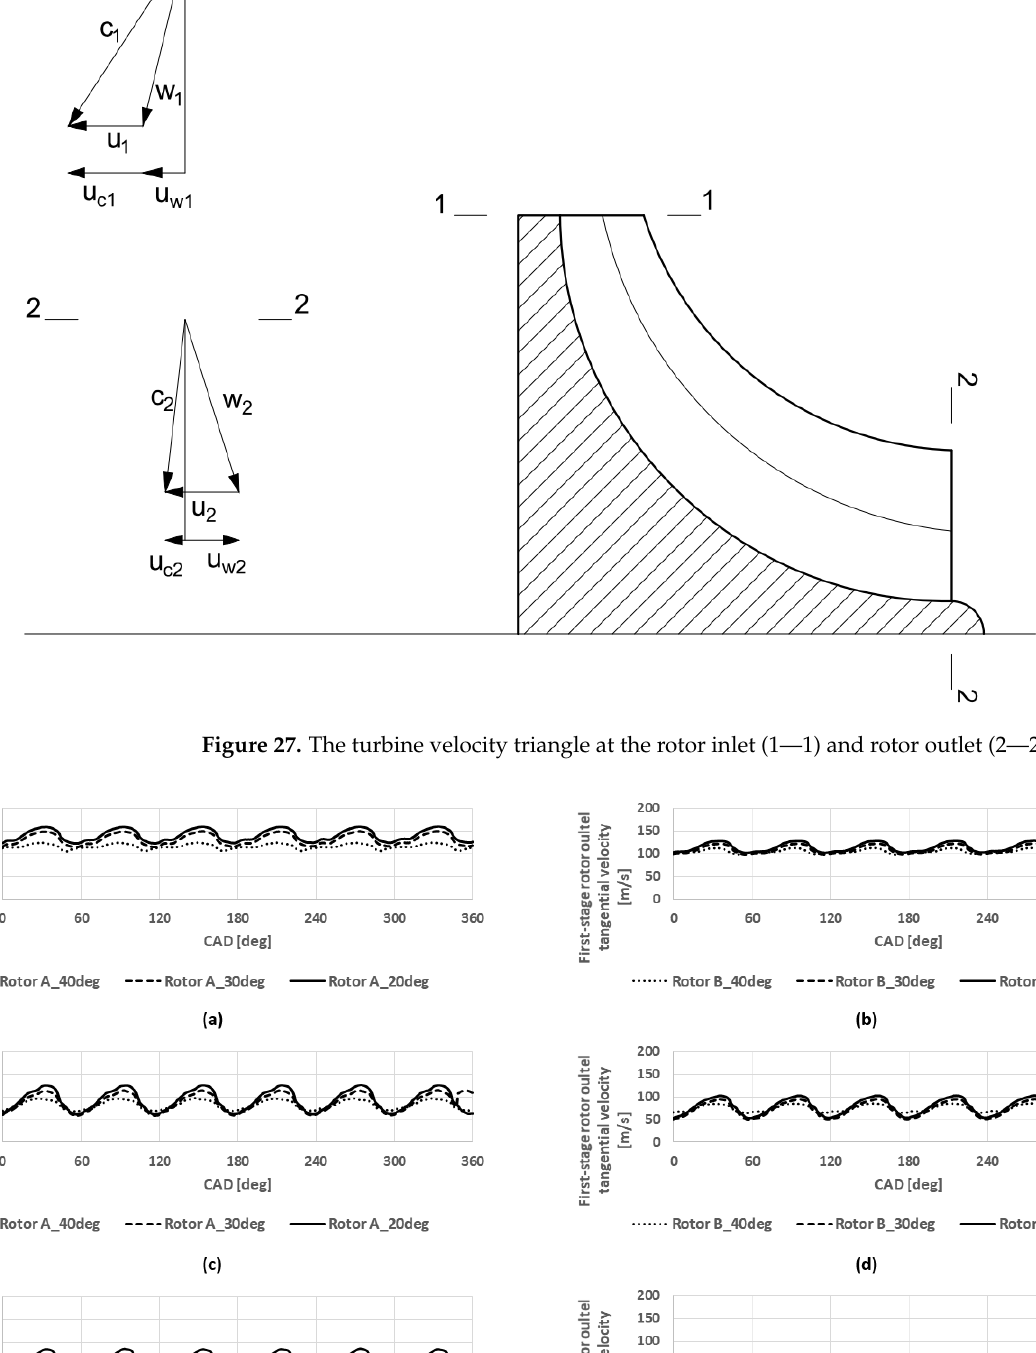
27.32 The velocity streamlines at the outlet from the first-stage rotor at the extreme cases are shown in Figure 29. Figure 29 shows the velocity streamlines of the first-stage rotor at the four extreme cases, which indicated the lowest and highest values of tangential velocity for both rotor geometries. A highly tangential flow of the exhaust gases was observed for the 60,000 rpm, 40° VTG case for both rotors. However, the tangential component was significantly re- duced in the 40,000 rpm, 40° VTG case for each rotor geometry. The flow at the first-stage rotor outlet was very chaotic; thus, the configuration of the velocity streamlines shown in Figure 29 might deviate from the parameters presented in Table 12 as those values were area-averaged over the rotor outlet surface.